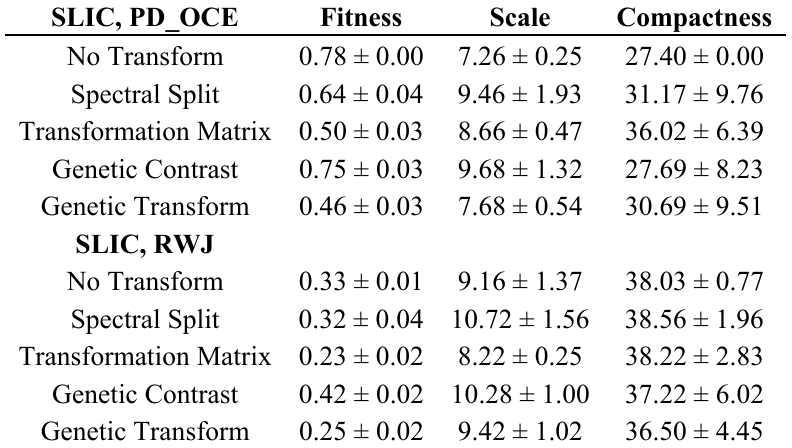
Table 7. SLIC segmentation algorithm parameters obtained over different metric and data transformation function conditions for the Bokolmanyo test site